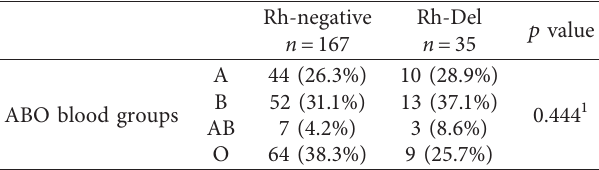
Table 3: Association of Rh-negative and Rh-Del among ABO blood groups ( N � 202).